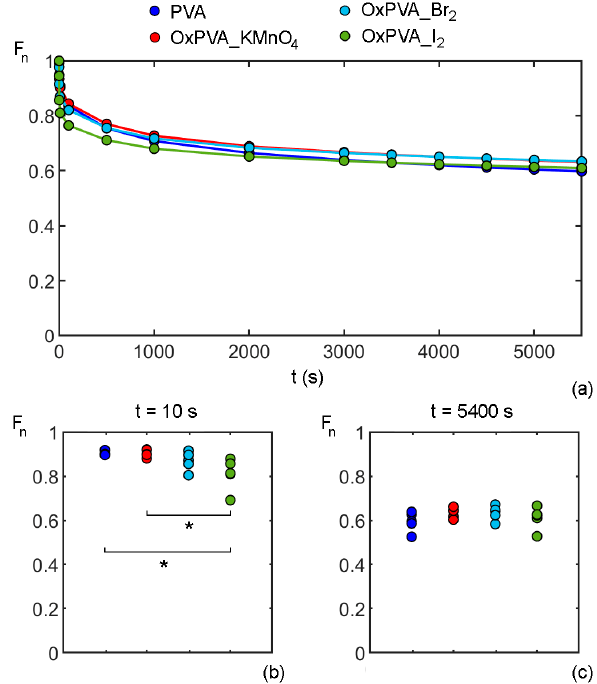
Figure 3. Results of consolidation tests of native and oxidized PVA hydrogels: ( a ) mean of normalized indentation force F n vs. time; values of F n for each sample of PVA hydrogels at different time instants, i.e., ( b ) 10 s and ( c ) 5400 s, during consolidation test. A significant difference among hydrogels is indicated by an asterisk (*) with p -value < 0.05.